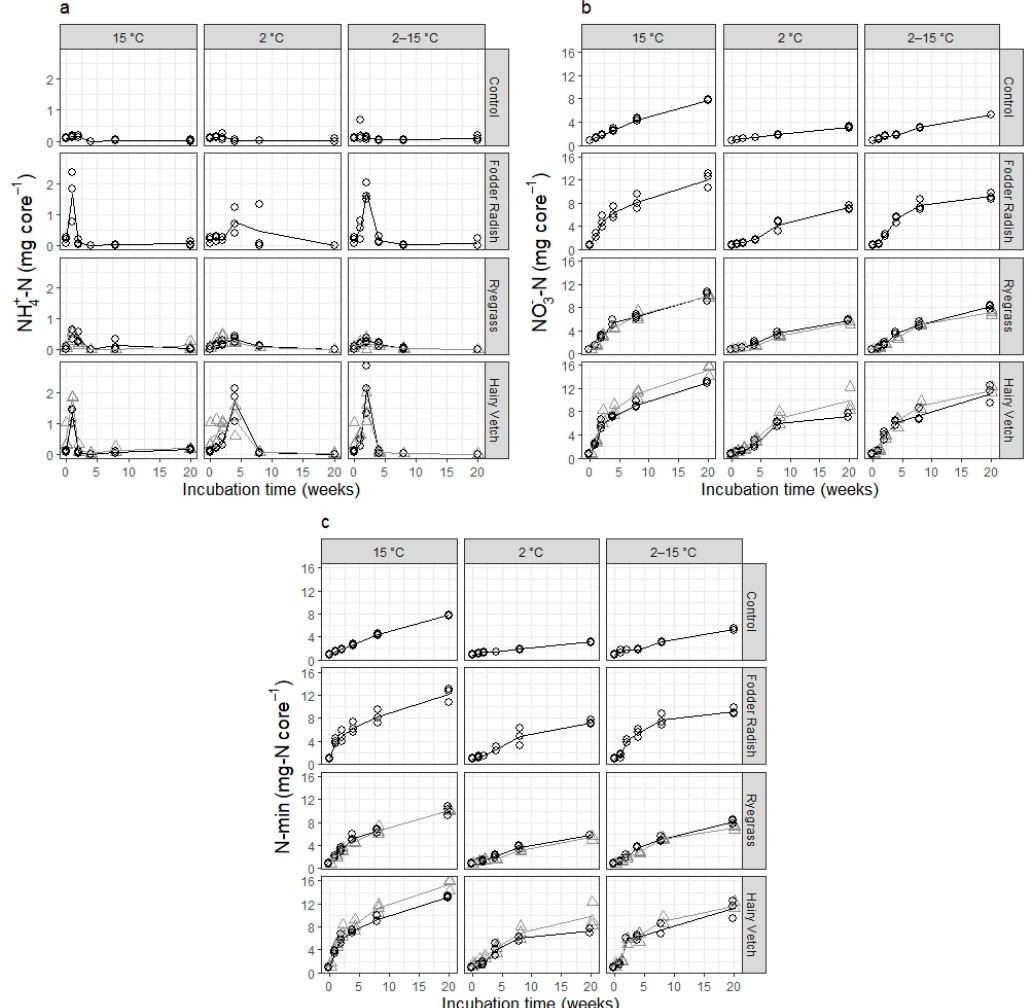
Figure 1. ( a ) Ammonium-N, ( b ) nitrate-N and ( c ) total mineral nitrogen in soil cores containing catch crop residue incubated at high (15 °C), low (2 °C) and variable (2–15 °C) temperatures. The gray lines and triangles ( ∆ ) represent the chemically terminated catch crops, while the black lines and circles ( ○ ) represent untreated catch crops. Symbols represent individual measurements, while lines represent mean values. All amounts are reported as total weight (in mg of N) per soil core (~250 mg dry weight).